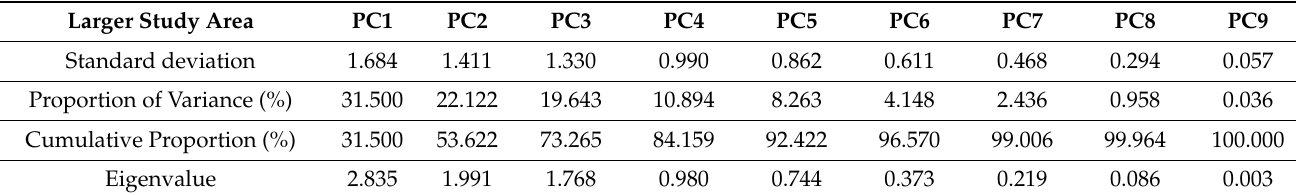
Table 3. Eigenvalues for the larger study area.